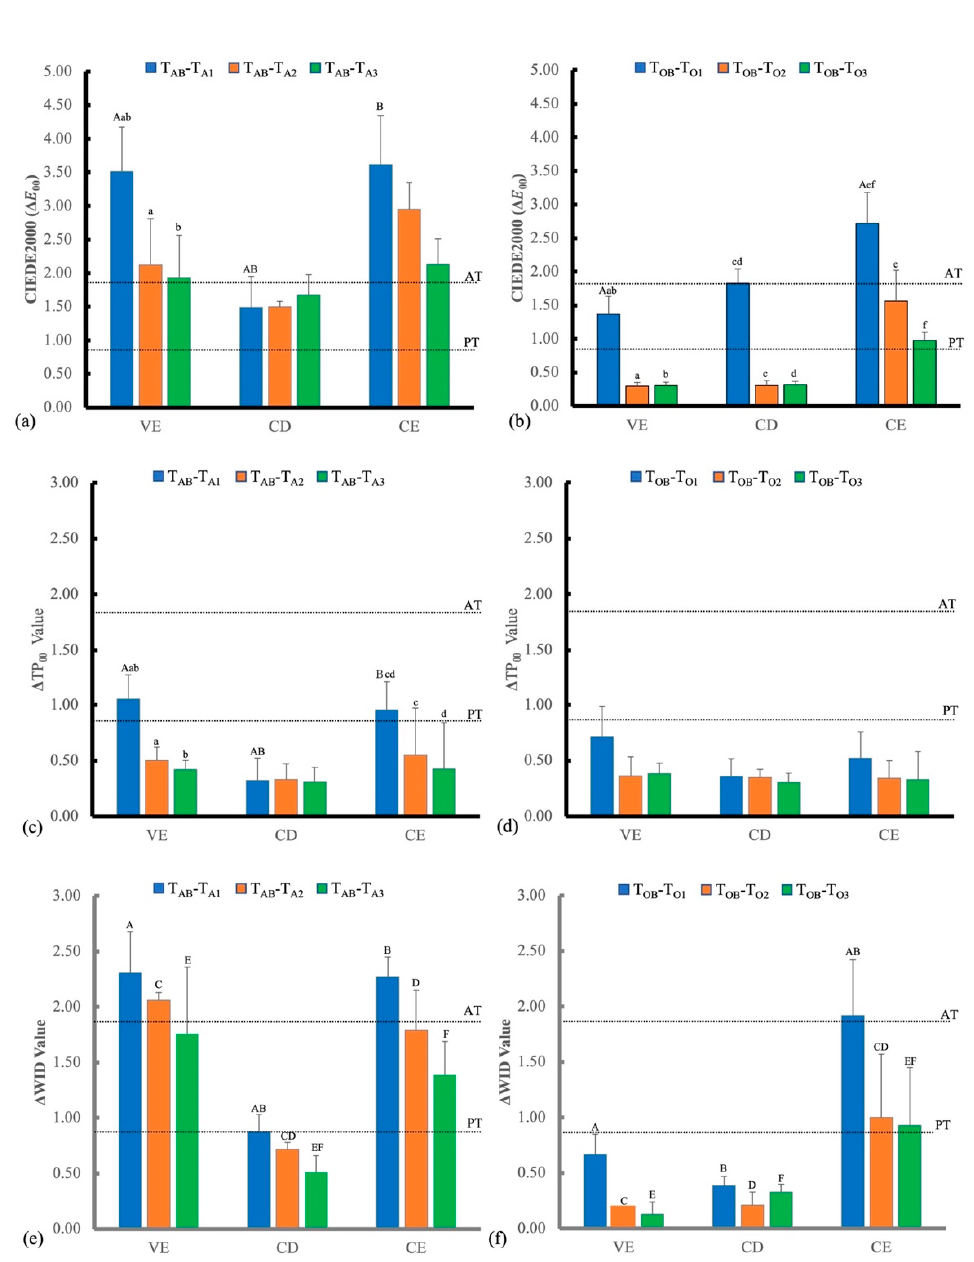
Figure 4. Color difference ( ∆ E 00 ), changes in translucency parameter ( ∆ TP 00 ), and changes in white- ness index ( ∆ WI D ) values of the three materials before (T AB , T OB ) and at different bleaching times for each material from the at-home ( a , c , e ) and in-office ( b , d , f ) groups. The 50:50% perceptibility thresh- old (PT) for ∆ E 00 , ∆ TP 00 , and ∆ WI were 0.8, 0.6, and 0.7, respectively, and the 50:50% acceptability threshold (AT) for ∆ E 00 , ∆ TP 00 , and ∆ WI were 1.8, 2.6, and 2.6, respectively. Subgroups identified by same superscript lowercase letters statistically differed within groups; subgroups identified by same superscript uppercase letters also statistically differed between groups (p < 0.05).